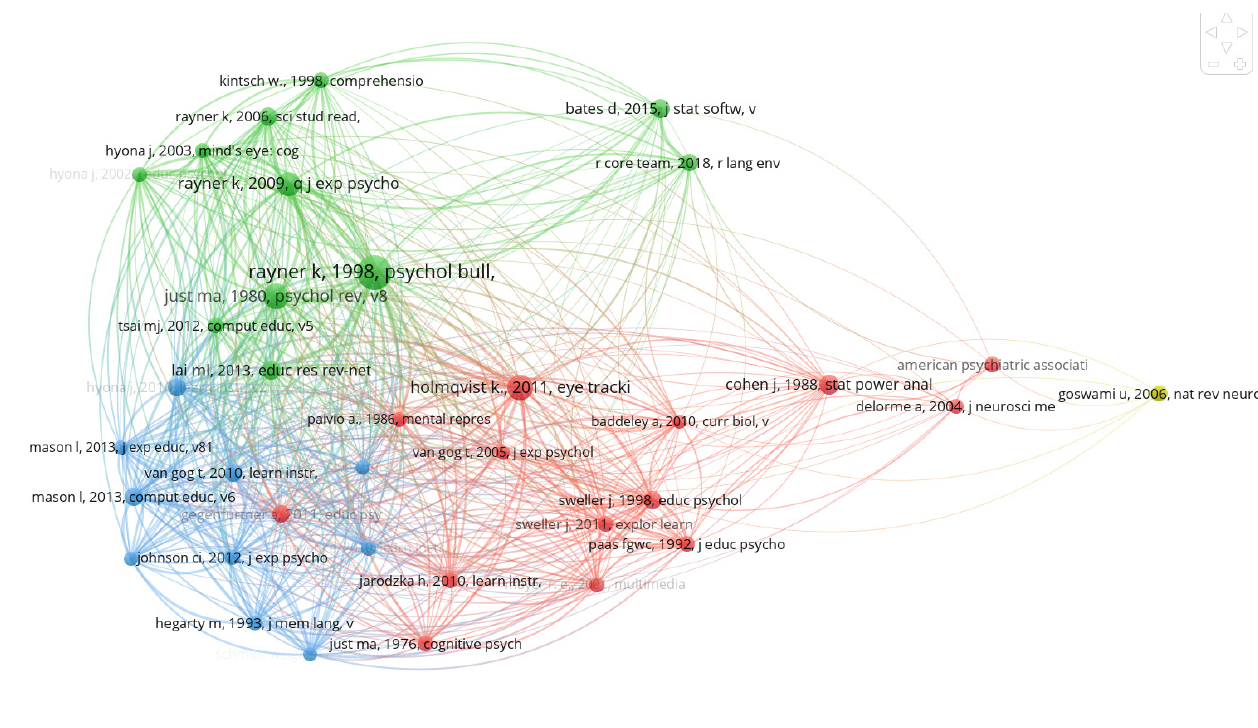
Figure 6. Co-citation network.